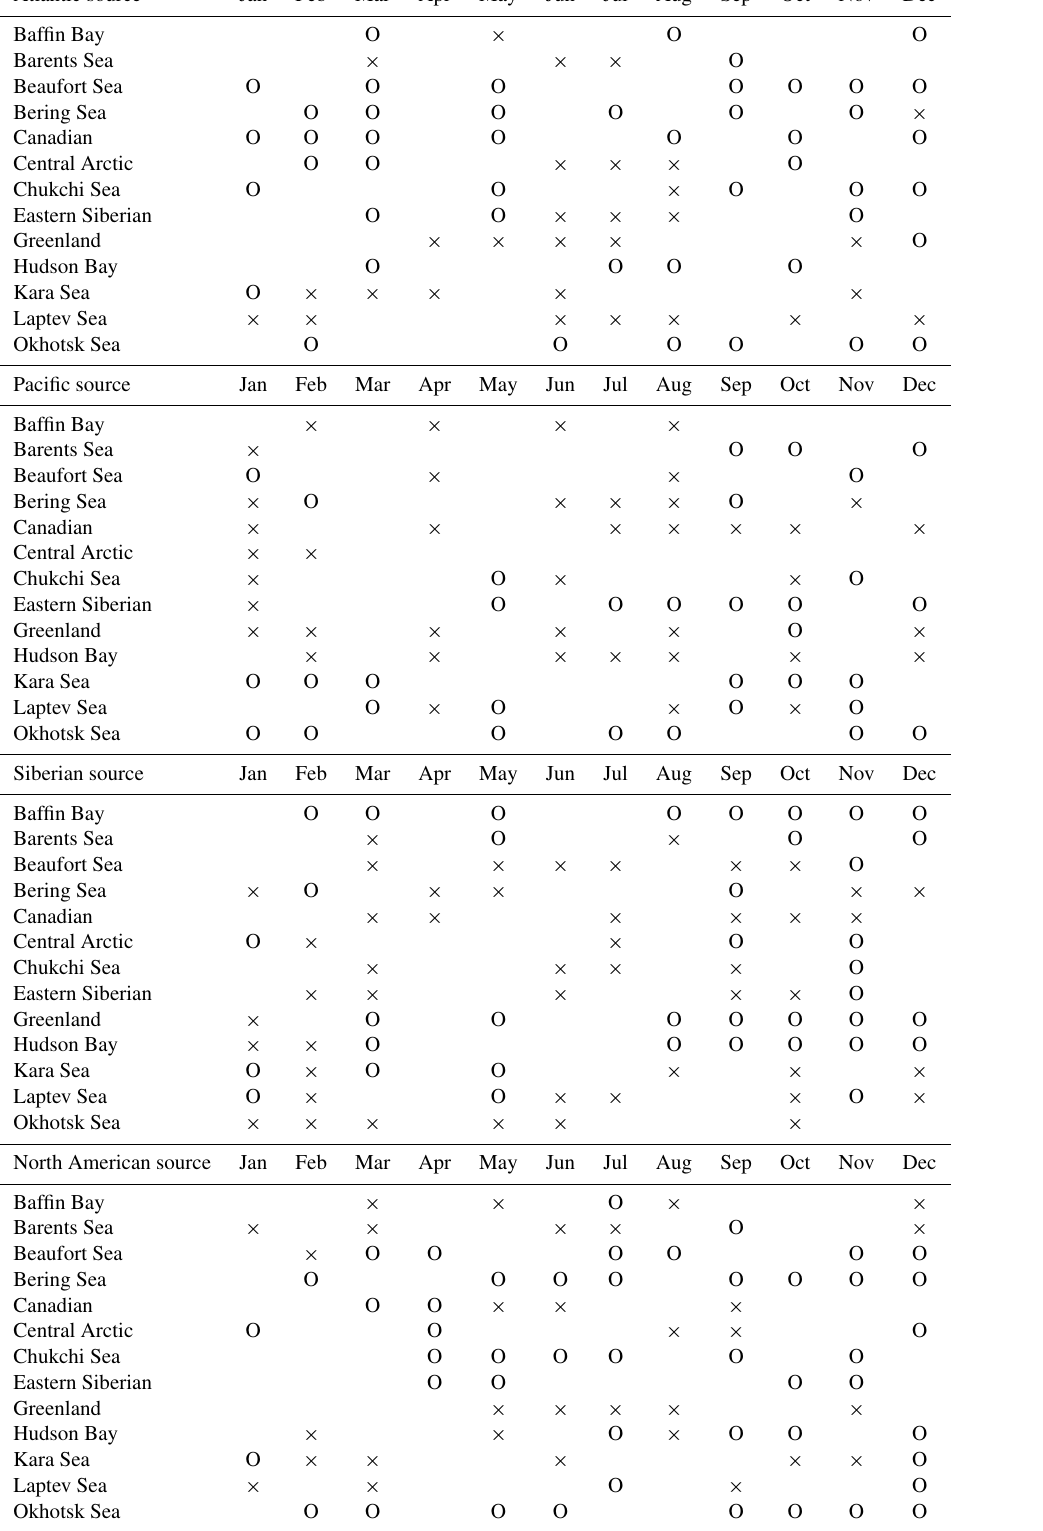
Table 1. Summary of the statistical significance of the MTP differences estimated by comparing daily values of moisture transport before and after the CP, based on the Student’s t test. Circles indicate statistical significance at the 95% confidence level for increases after the CP; crosses indicate statistical significance at the 95% confidence level for decreases after the